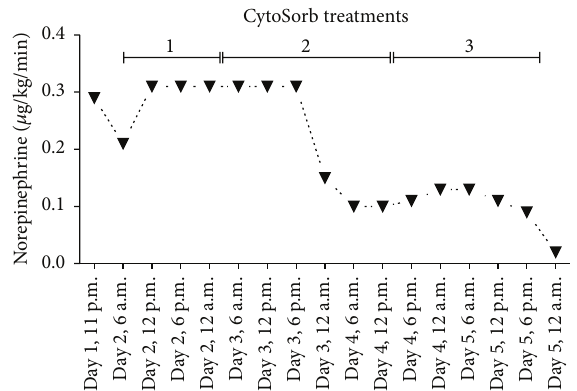
Figure 3: Need for norepinephrine throughout the treatment period.